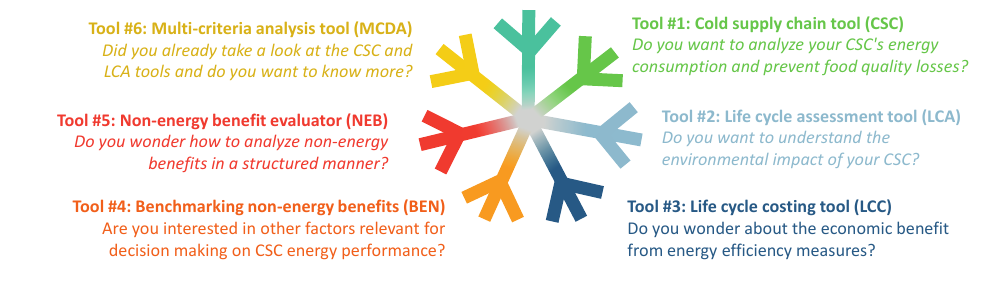
Fig. 2. Structure of the ICCEE